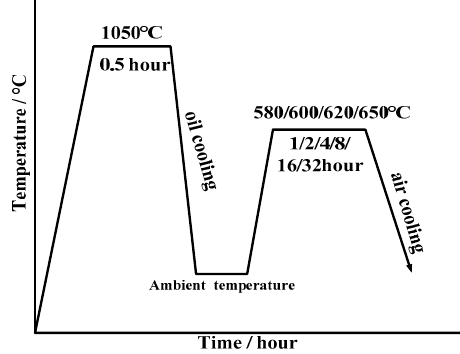
Figure 1. The heat treatment process of the samples in 13Cr supermartensitic stainless steel. The specimens were measured by a Bruker D8 Advance diffractometer (Bruker, AXS, Karlsruhe, Germany), operated at 40 kV and 40 mA using Cu radiation for XRD analysis. The polished samples were measured from 30° to 90°at a speed of 1° per minute. The amount of reverted austenite was determined by XRD from a Rietveld analysis. The analysis was refined by the Rietveld-analysis preferred orientation, lattice parameters, the pseudo-Voigt profile parameters and the scale factor of the phases were refined independently but not simultaneously. The lattice constant and the volume process.